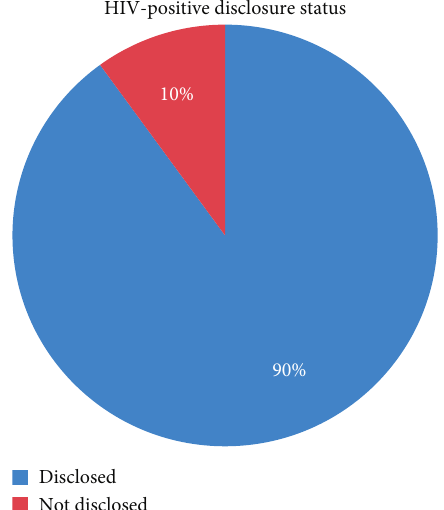
Figure 1: -Magnitude of HIV-positive status disclosure among adult ARTpatients attending ARTclinics at public health facilities of Butajira town, Southern Ethiopia, 2019 ( n � 405). Table 4: Multivariable logistic regression analysis for factors associated with HIV-positive status disclosure among ARTpatients attending ART clinic in public health facilities of Butajira town, Southern Ethiopia, 2019 ( n � 405).